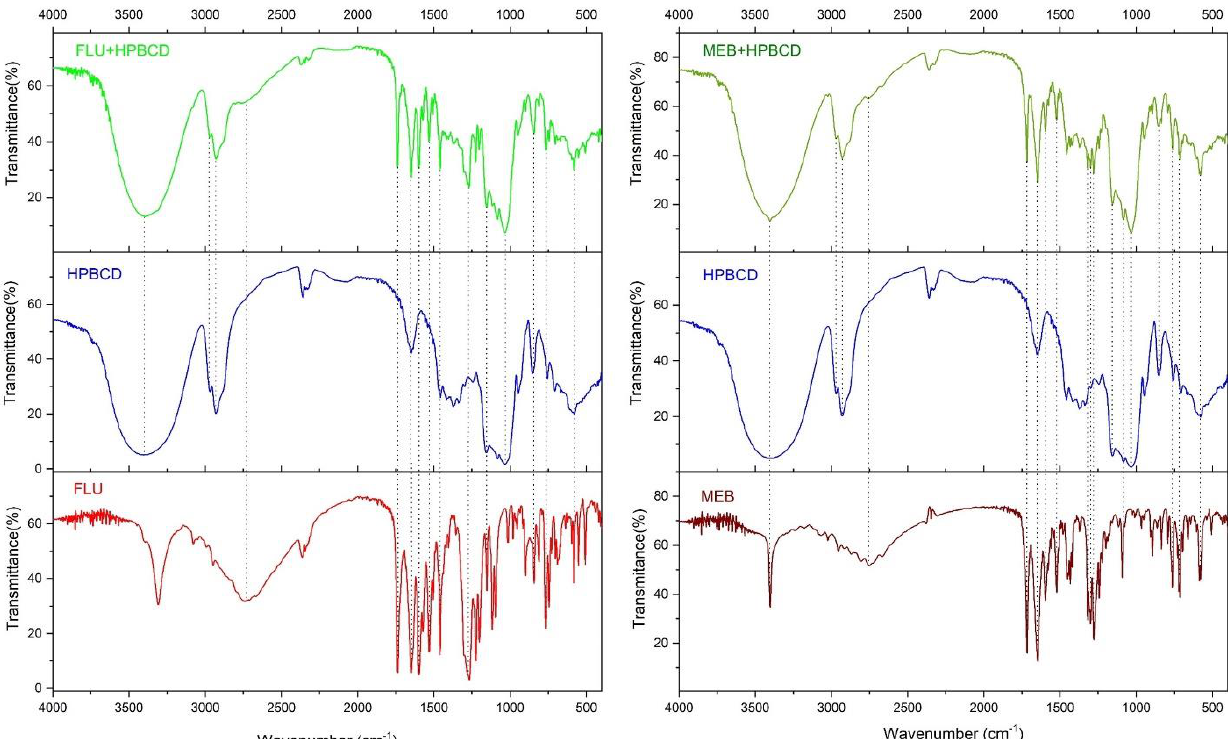
Figure 6. FTIR spectra of FLU, MEB, and their HPBCD conjugates.